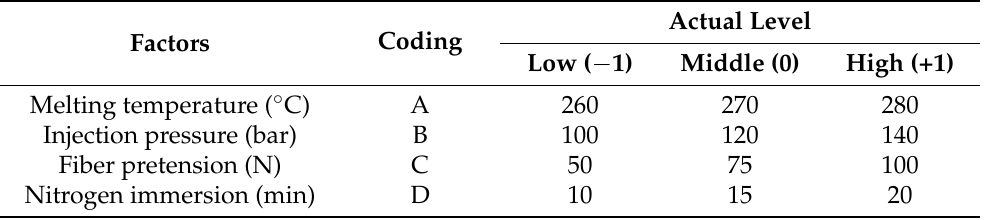
Table 3. Parameter factors and levels.